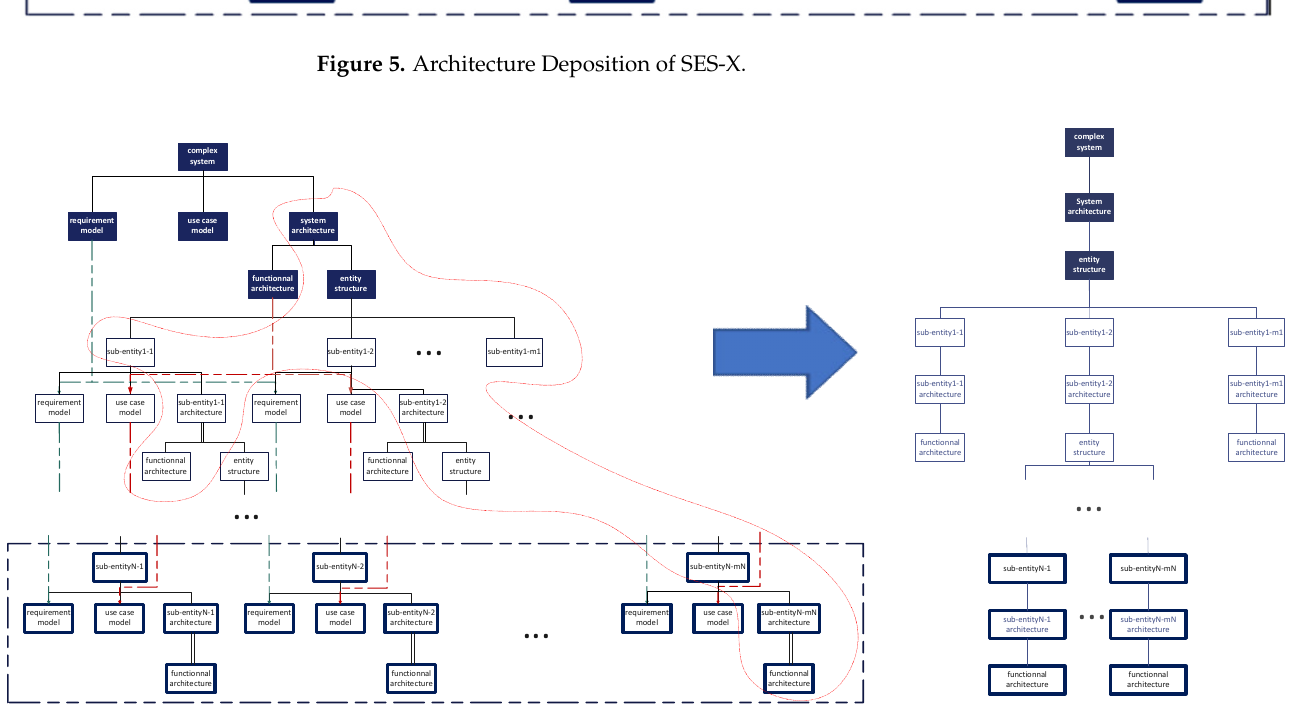
Figure 6. Architecture pruning of SES-X.